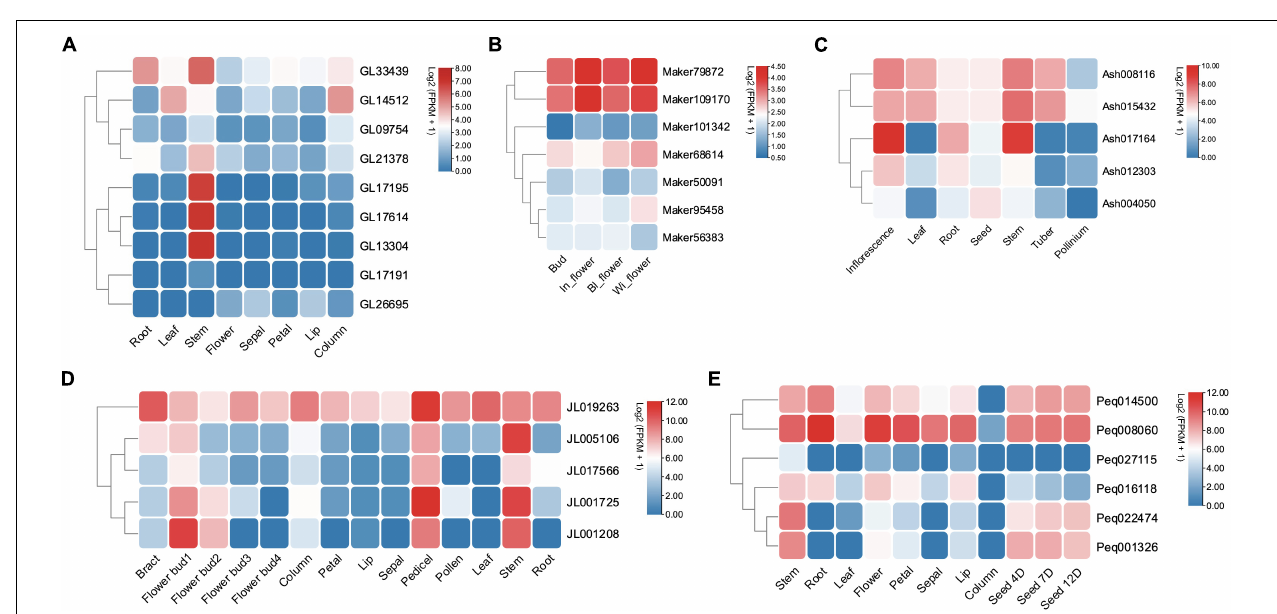
FIGURE 5 | Cis -acting elements in the promoter regions of KNOX genes. Elements with similar regulatory functions are displayed in the same color. Numbers of each type of element are shown on the right side.